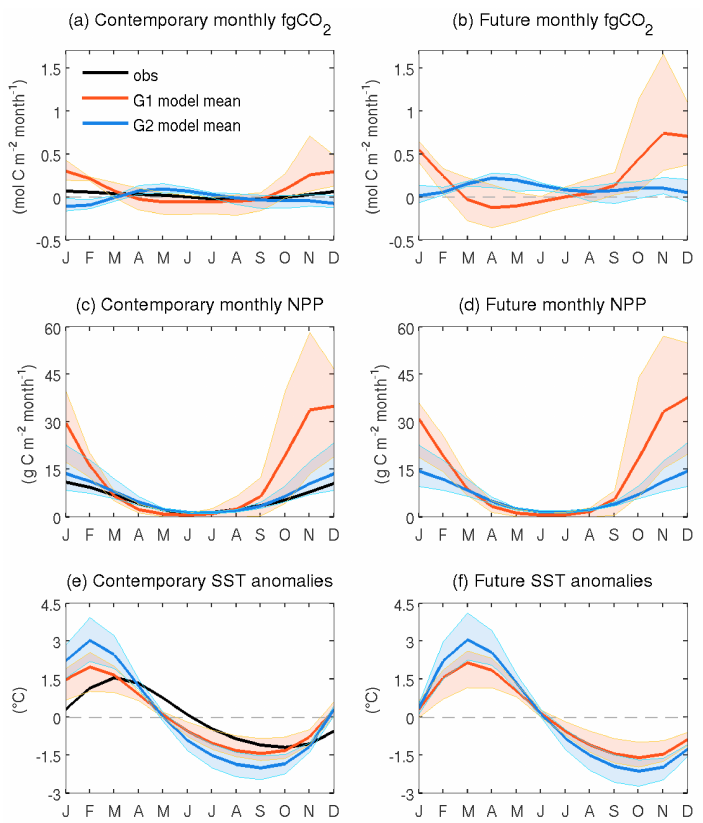
Figure 7. Seasonal cycle of (a–b) carbon flux, (c–d) NPP, and (e–f) SST anomalies for the Southern Ocean region simulated by CMIP5 models for the 2001–2010 (left panels) and 2090–2099 (right panels) decades. The red (blue) shadings represent the range of G1 (G2) models that simulate anomalously strong (weak) carbon uptake (see also text in Sect. 3.3). The colored lines represent the mean of the respective model groups, black lines represent the observational estimate adopted from Landschützer et al. (2014) for CO 2 uptake and SST anomaly, and the NPP was taken from SeaWiFS data as described in Nevison et al.